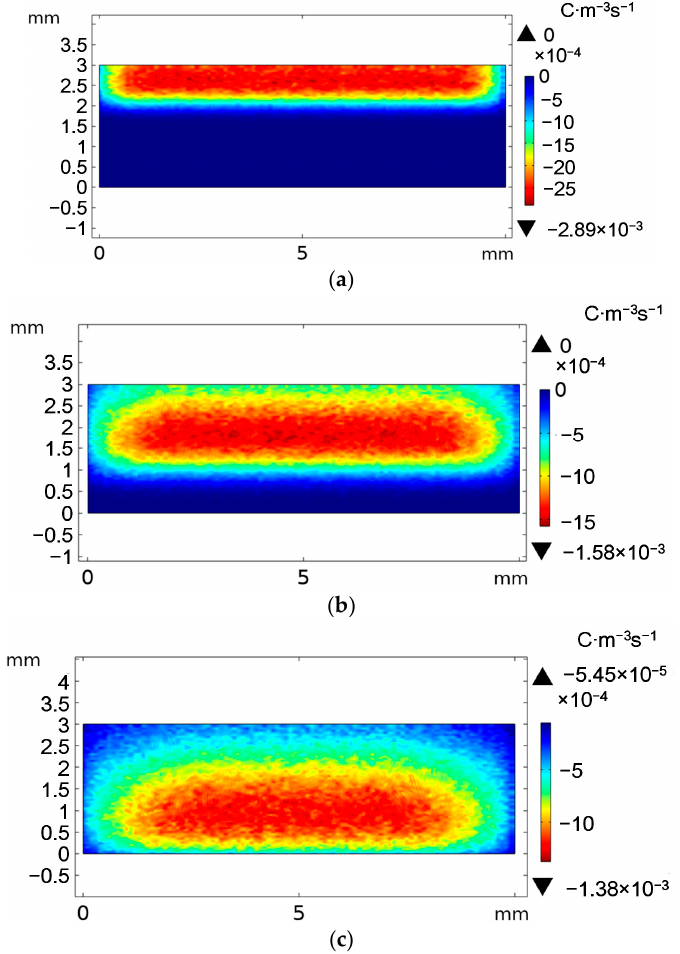
Figure 8. Calculation results of charge deposition rate by the joint simulation method under different electron energies: ( a ) 0.7 MeV, ( b ) 1.0 MeV, ( c ) 1.3 MeV.